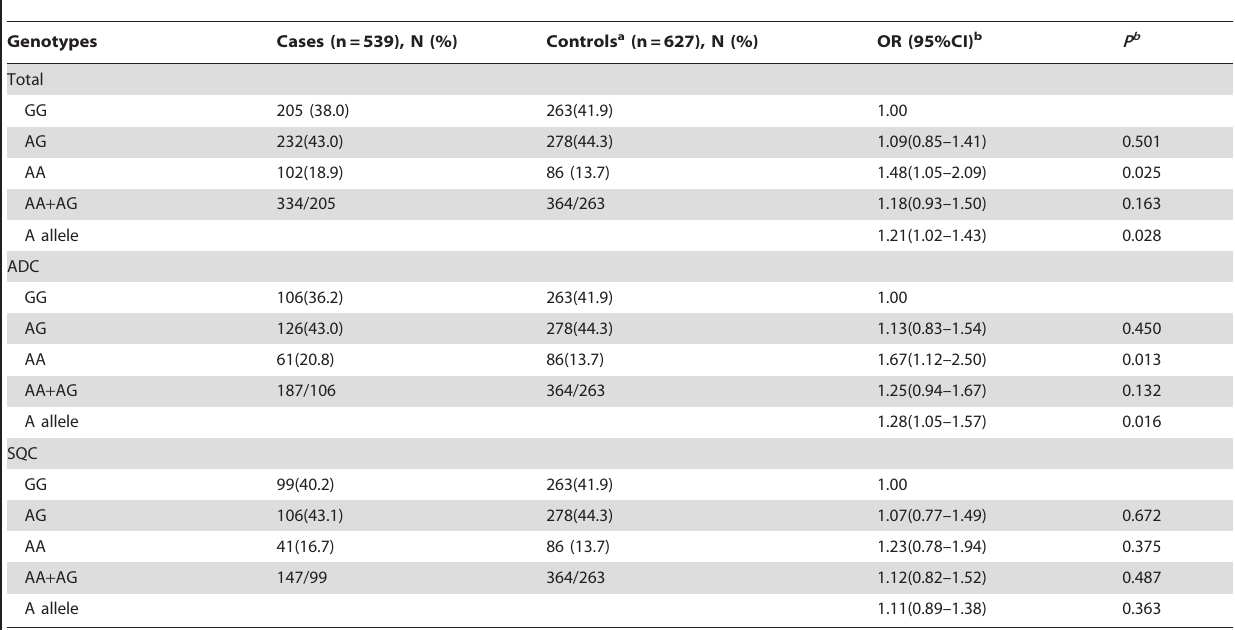
Table 2. Association between the rs2736098 polymorphism and non-small-cell lung cancer risk in a Chinese Han population.